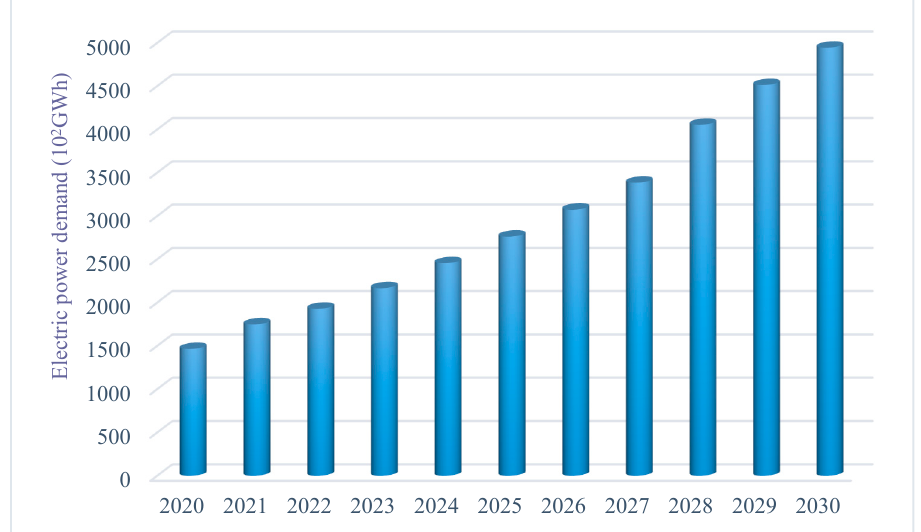
Figure 3. The prediction of the electric power demand from 2020 to 2030.